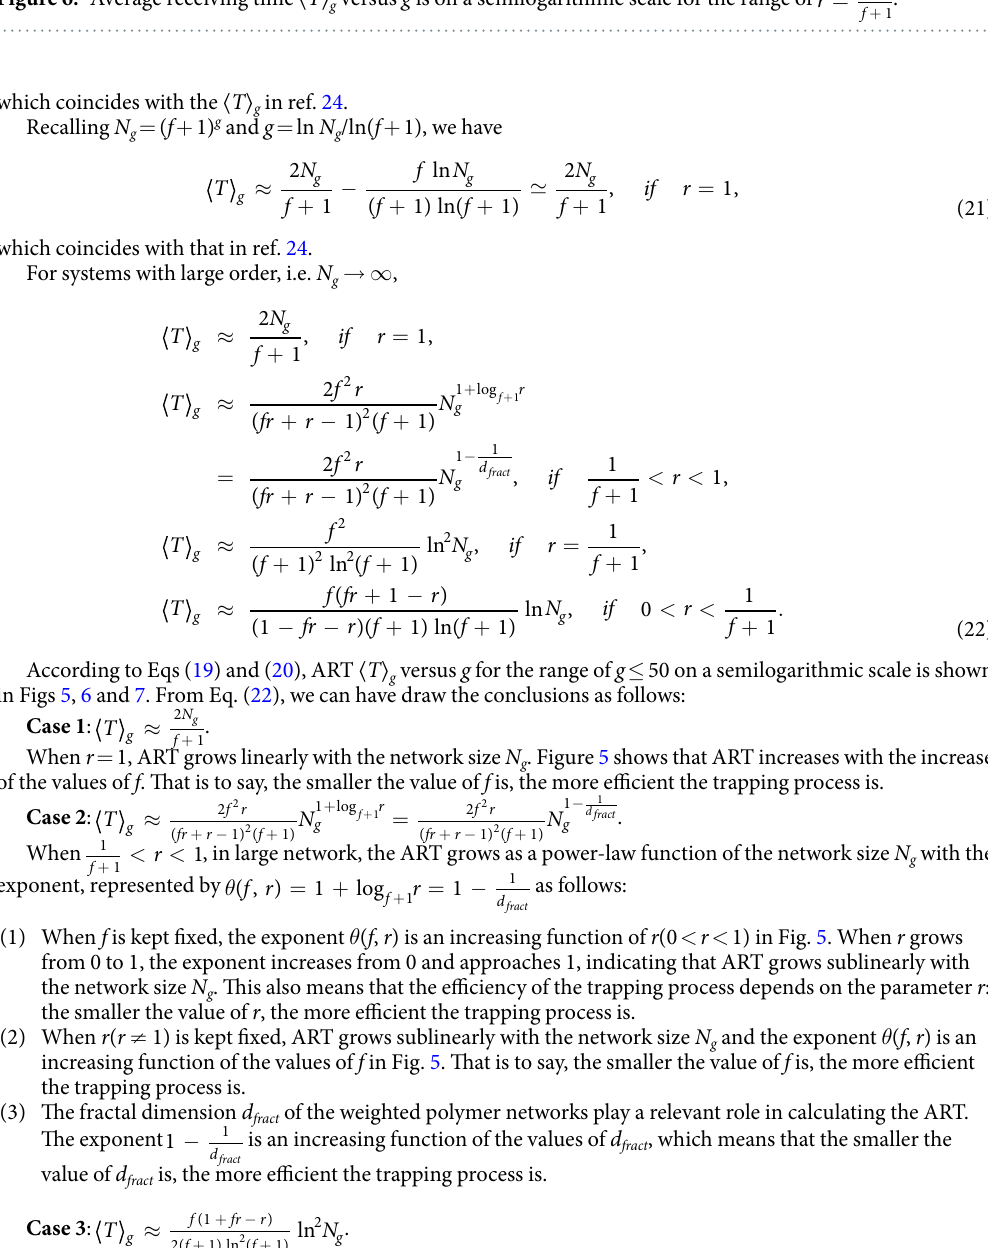
Figure 6. Average receiving time 〈 T 〉 g versus g is on a semilogarithmic scale for the range of =